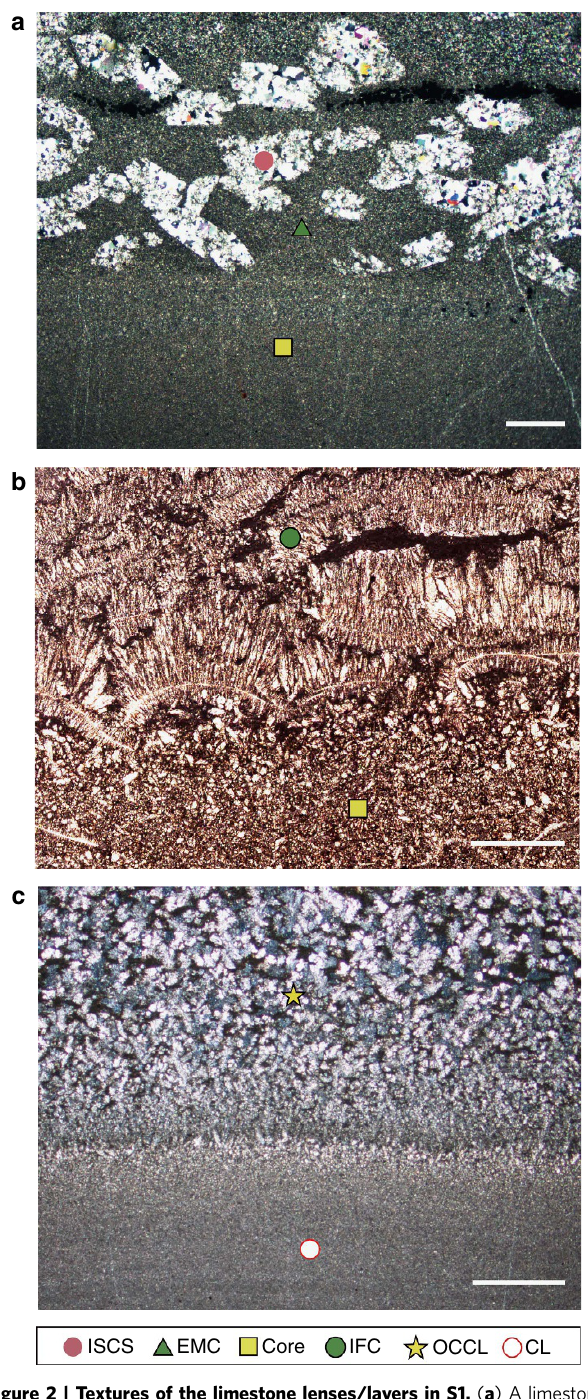
Figure 2 | Textures of the limestone lenses/layers in S1. ( a ) A limestone lens core surrounded by a cement fringe consisting of equigranular microcrystalline calcite (EMC), irregular-stacked calcite spar (ISCS) and pyrite bands (black). ( b ) A limestone lens core surrounded by layers of isopachous fibrous calcite (IFC). ( c ) The central layer (CL) of a thin limestone layer surrounded by outward-coarsening calcite laminae (OCCL). d 13 C carb values of subsamples are shown in Fig. 3. Scale bar, 1mm. a and c are shown with cross-polarized light, whereas b is shown with plane-polarized light.